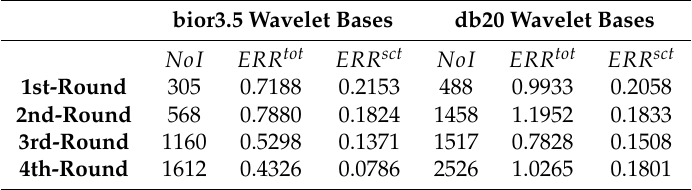
Table 3. Errors of the reconstructed results by WT-TSOM with the bior3.5 and db20 wavelet